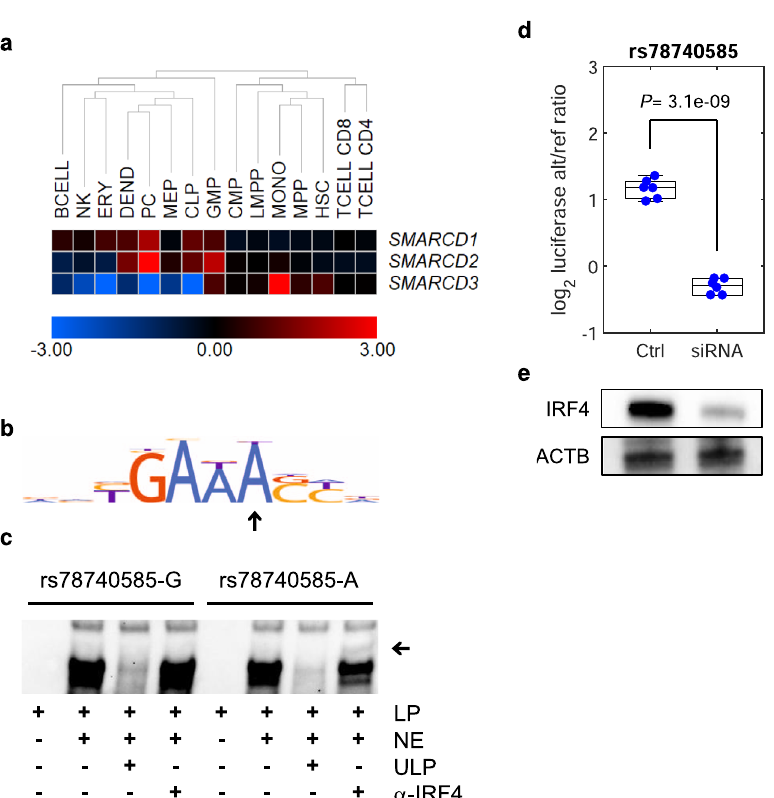
Fig. 5 Characterization of rs78740585. a Heat map showing the expression of the SMARCD gene family in blood cells. Notably, expression of SMARCD3 in plasma cells is normally very low; the MM risk allele upregulates SMARCD3 in this cell type (Supplementary Table 2). The color scale is log 2 -transformed, median-centered RNA-seq data 23 . b Motif analysis predicted that the SMARCD3 high-expressing rs78740585-A allele creates a binding site for IRF4. Arrow indicates the altered recognition base. c Electromobility shift assay showing selective binding of IRF4 to rs78740585-A probe. Arrow indicates supershift with an antibody towards IRF4. d siRNA-knockdown of IRF4 reduced luciferase activity for rs78740585-A relative to rs78740585-G in L363 cells. The y -axis indicates the log 2 ratio of the luciferase/renilla signal for rs78740585-A relative to the rs78740585-G construct. The bottom, middle, and top of each box plot represent the 25th, 50th, and 75th percentiles. The whiskers represent the non-outlier minimum and maximum values, located at 1.5 times the interquartile range from the bottom and top of the box, respectively. The P value is for the two-sided Student ’ s t -test. e Western blot con fi rming knockdown. LP labeled probe, NE L363 nuclear extract, ULP unlabeled probe, α -IRF4 antibody against IRF4.